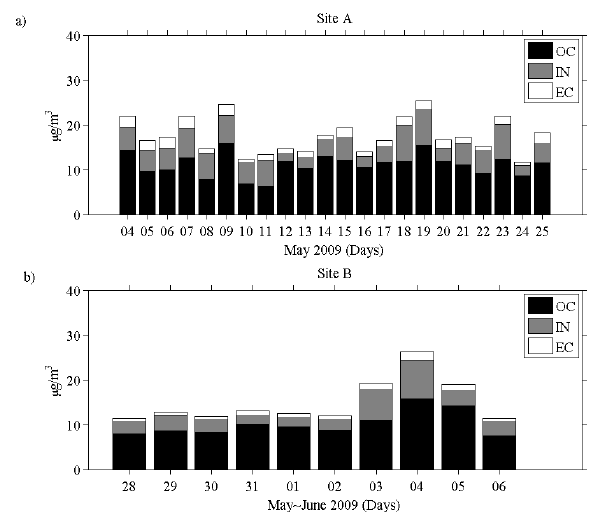
Figure 8: Comparison of measured elemental carbon, organic carbon (insoluble) , water soluble organic carbon /nitrogen and ionic composition of PM2.5 at Site A(left) and Site B (right) during the pre- monsoon season.